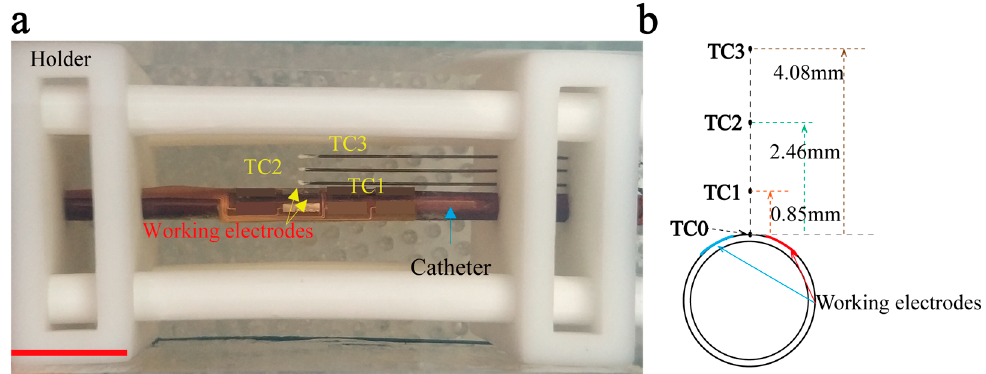
Figure 3. ( a ) Picture of the phantom with thermocouples (TC1, TC2, and TC3) and catheter. Scale bar: 1 cm. ( b ) The relative positions among the thermocouples, working electrodes, and catheter. Thermocouple TC0 measured the control point temperature. TC0, TC1, TC2, and TC3 represented the locations of the endothelial lining, plaque, adventitia, and surrounding tissue.